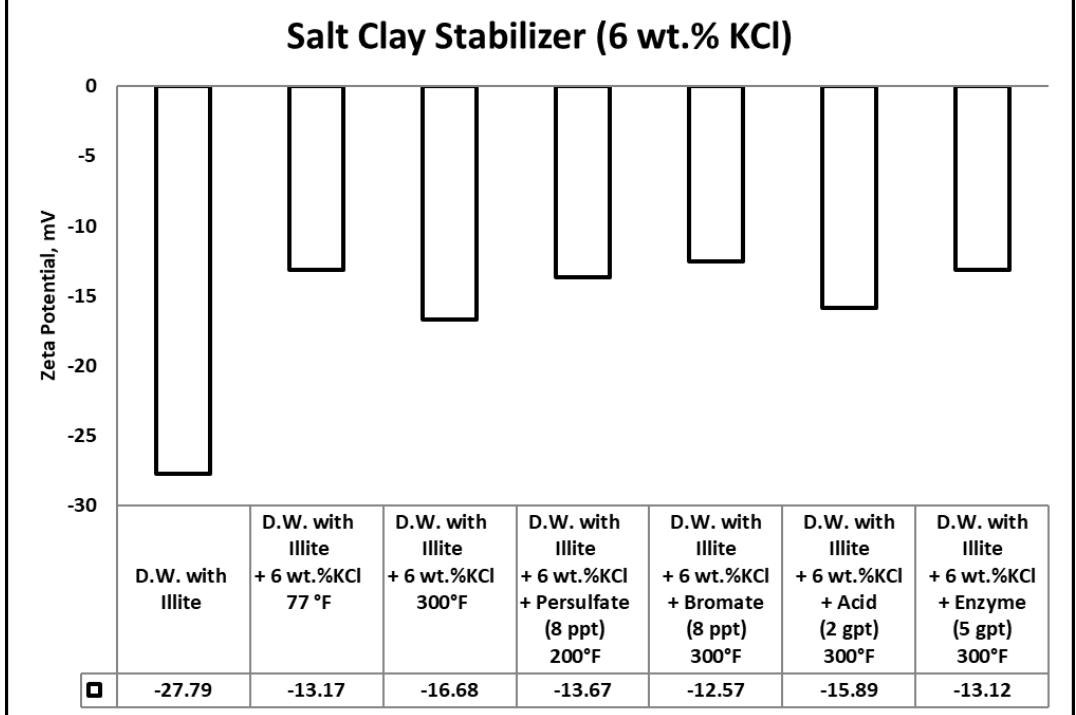
Figure 14. Zeta potential results for the tests involving gel breakers and KCl clay stabilizer.